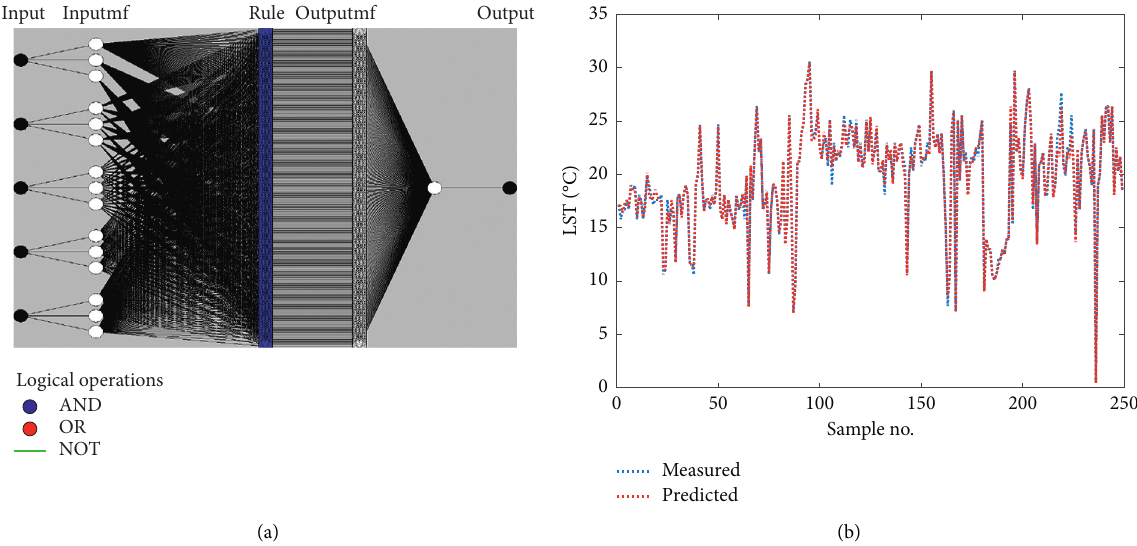
Figure 10: ANFIS model design and results. (a) ANFIS model diagram; (b) LST measurements and ANFIS prediction results.